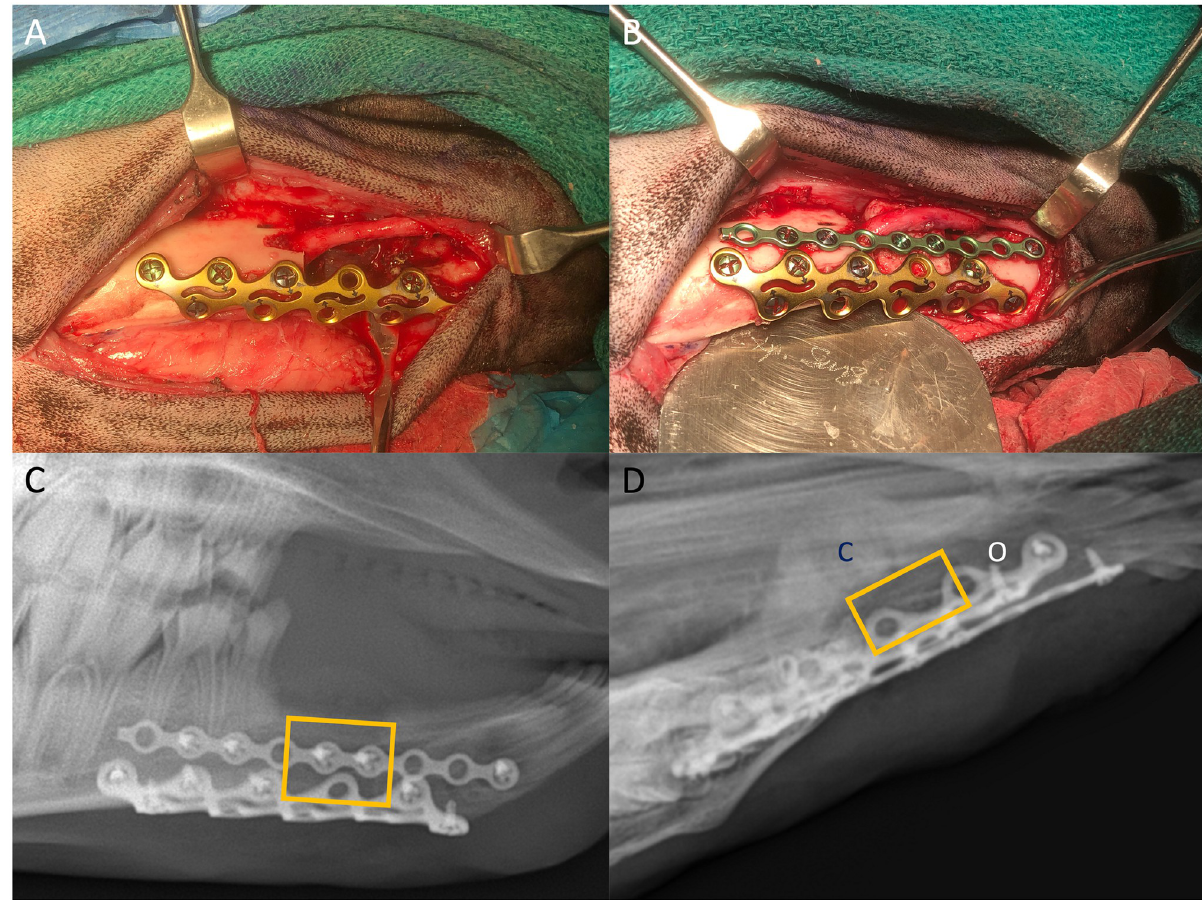
Fig 3. The two-plate strategy to provide additional inferior support to the mandible. Plating of the mandible with the rib plate (A), and a small lateral plate was used to hold the space maintainer in place (B). Initial X-rays (C) showed two plates and space maintainer (yellow box). Week 7 x-ray (D) showing medial callus formation and potential osteolysis associated with mucosal dehiscence observed at week 5.